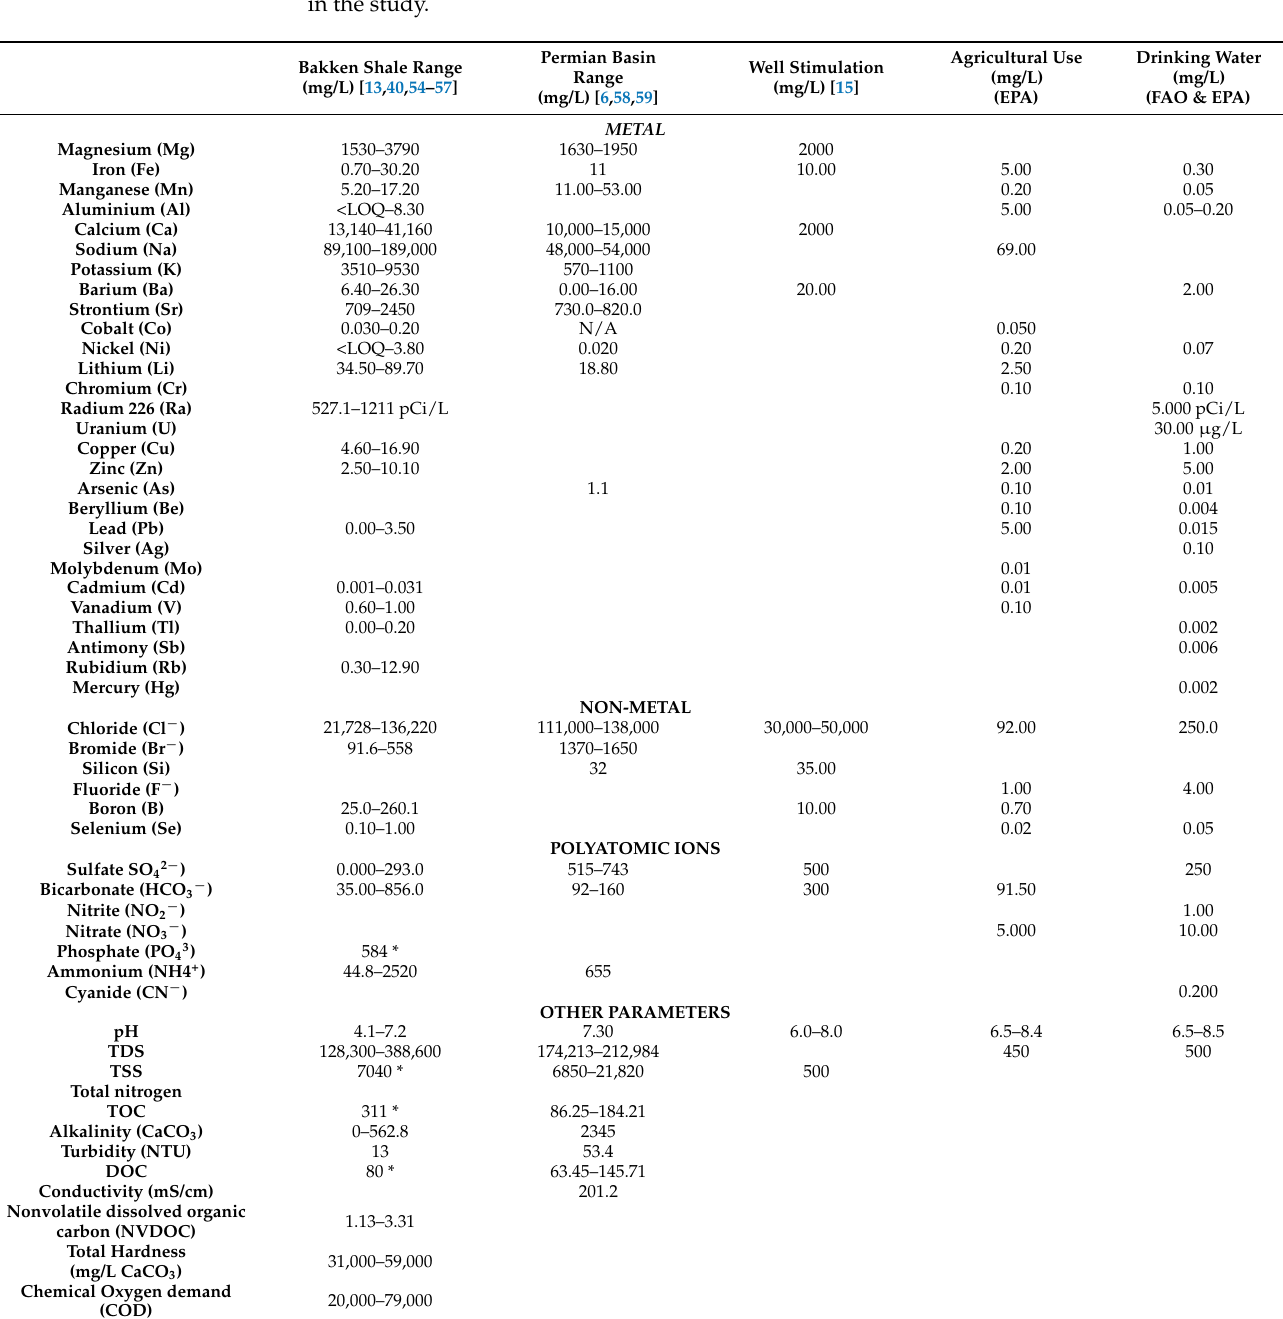
Table 1. Inorganic constituents and other parameters of fracturing waste waters from Bakken Shale and Permian Basin, the regulated concentration ranges for reuse in well stimulation [15] and in agricultural and consumption use [52,53]. * represents the reported average of three measurements in the